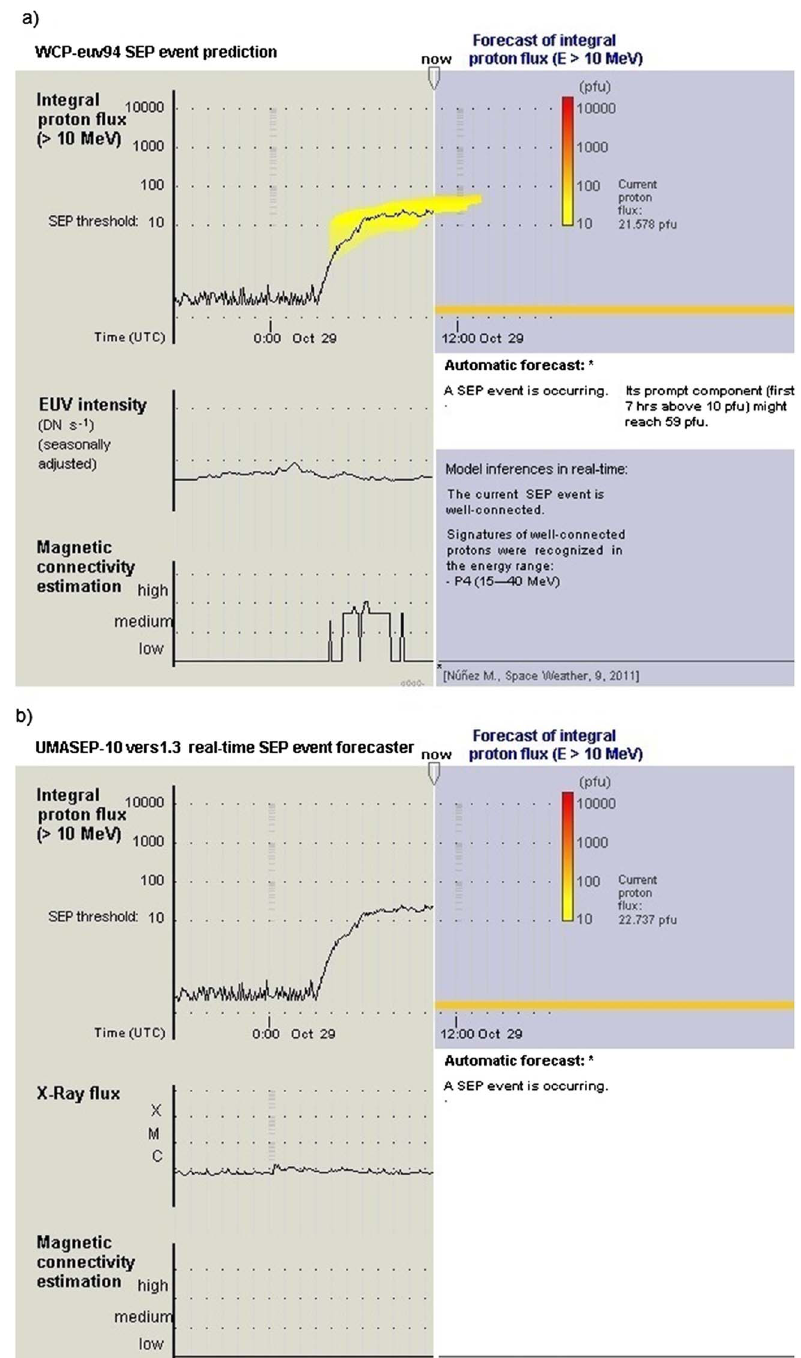
Fig. 5. Graphical output of WCP-euv94 and WCP-sxr (v1.3) for the SEP event on October 29, 2015, which was associated with a behind-the- limb fl are: (a) Prediction output using EUV 94 Å data. (b) Prediction using SXR